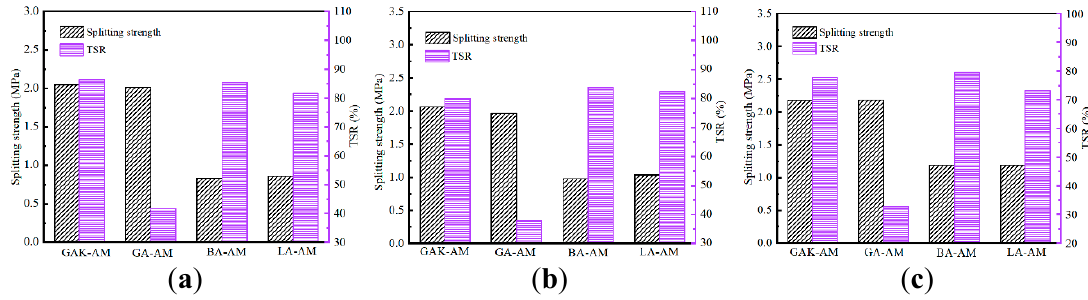
Figure 8. Freeze-thaw splitting tests of asphalt mixture: ( a ) unaged, ( b ) short-term aged, ( c ) long-term aged.